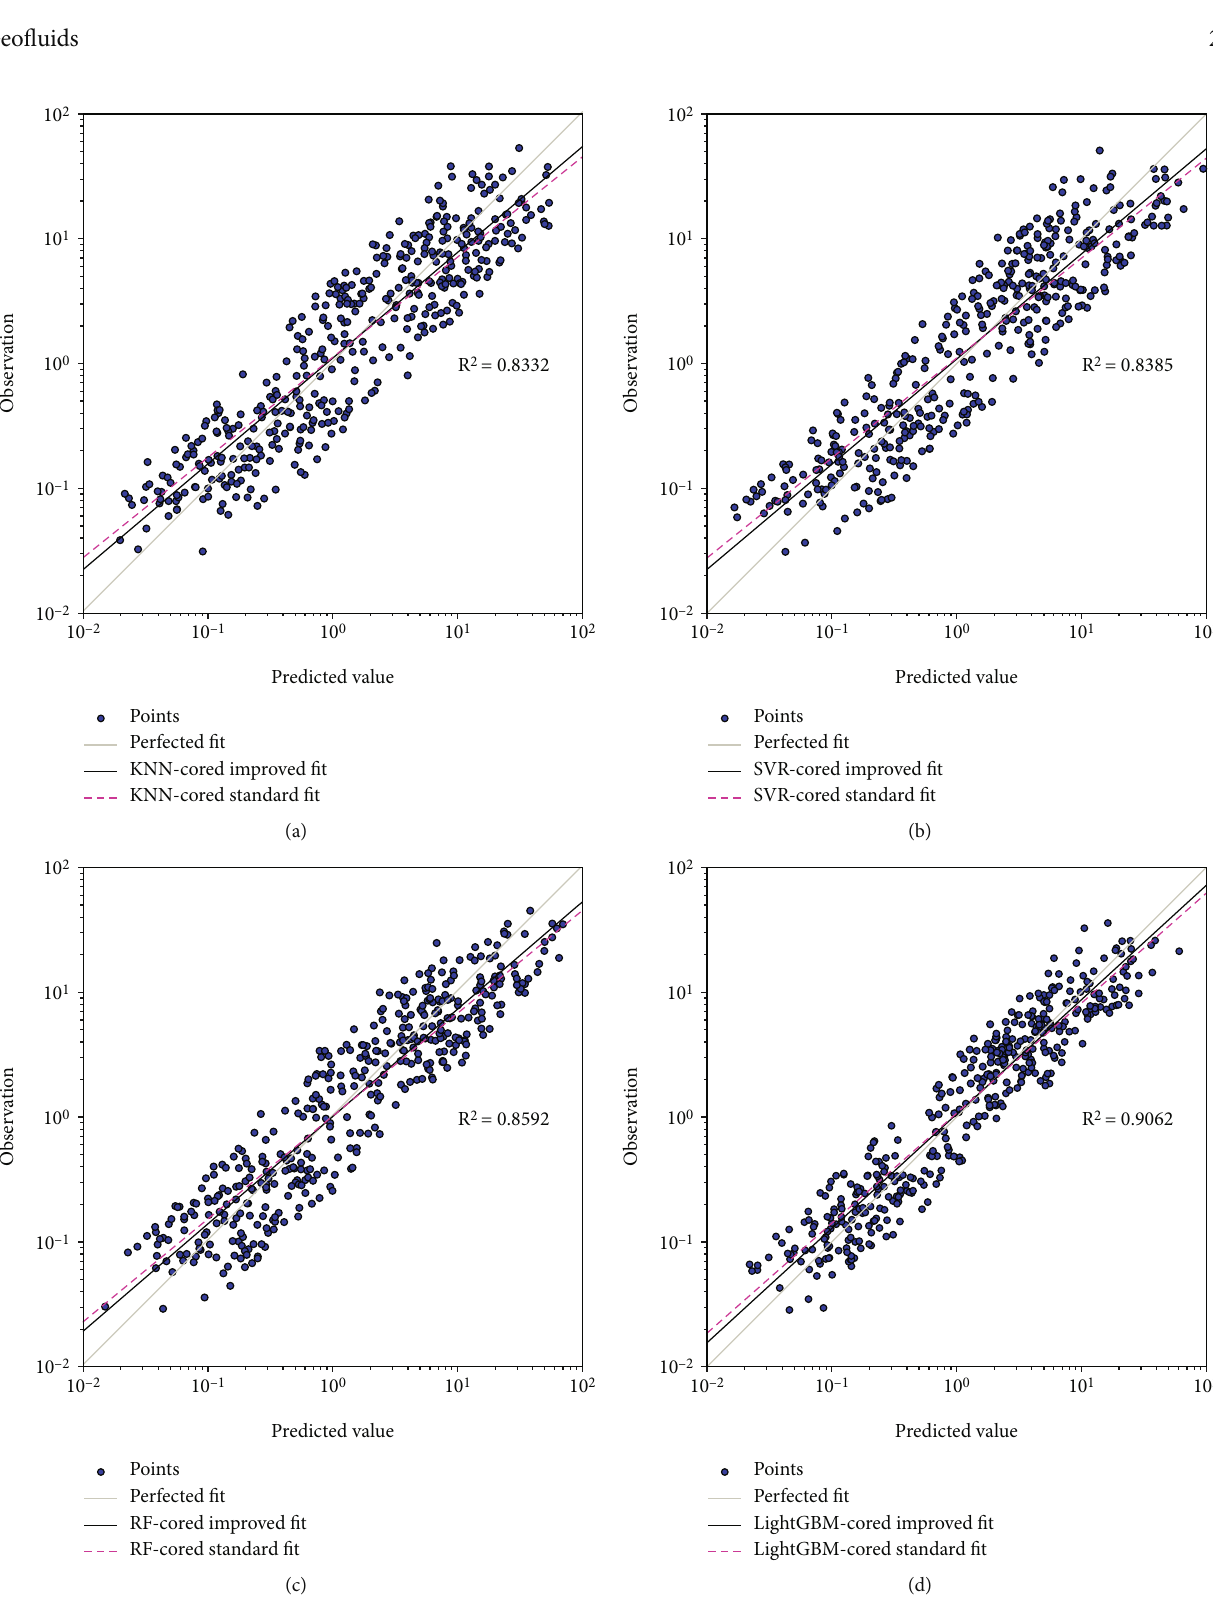
Figure 13: Fitness of permeability results provided by KNN-cored predictor (a), SVR-cored predictor (b), RF-cored predictor (c), and LightGBM-cored predictor (d) in the second experiment. “ standard fi t ” means the fi tting is gained in the fi rst experiment; KNN =k- nearest neighbors; SVR =support vector regression; RF =random forest; LightGBM=light gradient boosting machine; RMSE=root- mean-square